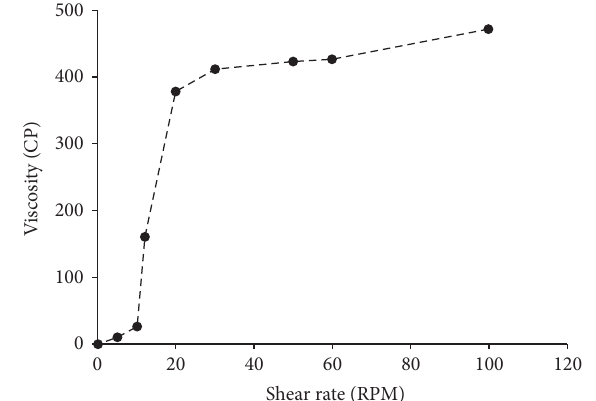
Figure 1: The rheological behavior of the extemporaneous prep- aration over different shear rates.